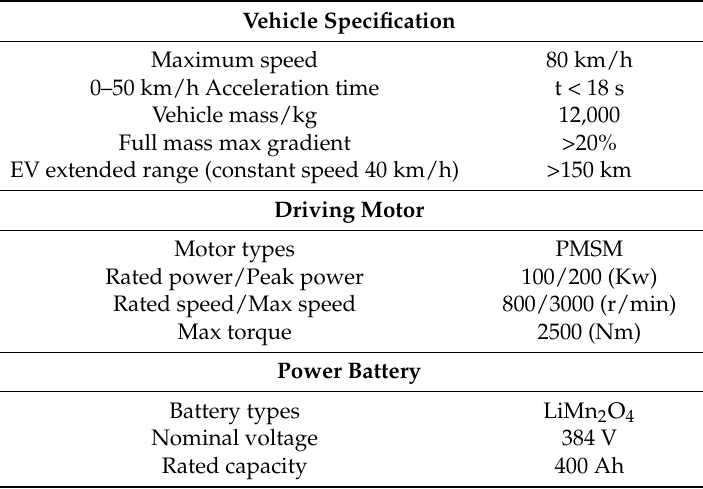
Table 1. Range-extended electric vehicle (RE-EV) bus specification parameters.